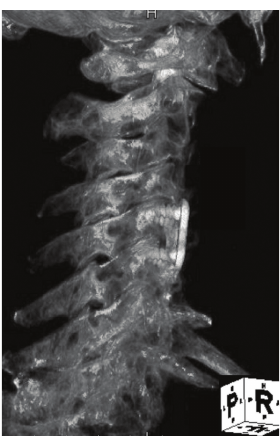
Figure 5: A constructed picture simulating the second intraopera- tive radiogram was obtained from 3D CT after the surgery. The plate appeared to bridge the C5 and C6